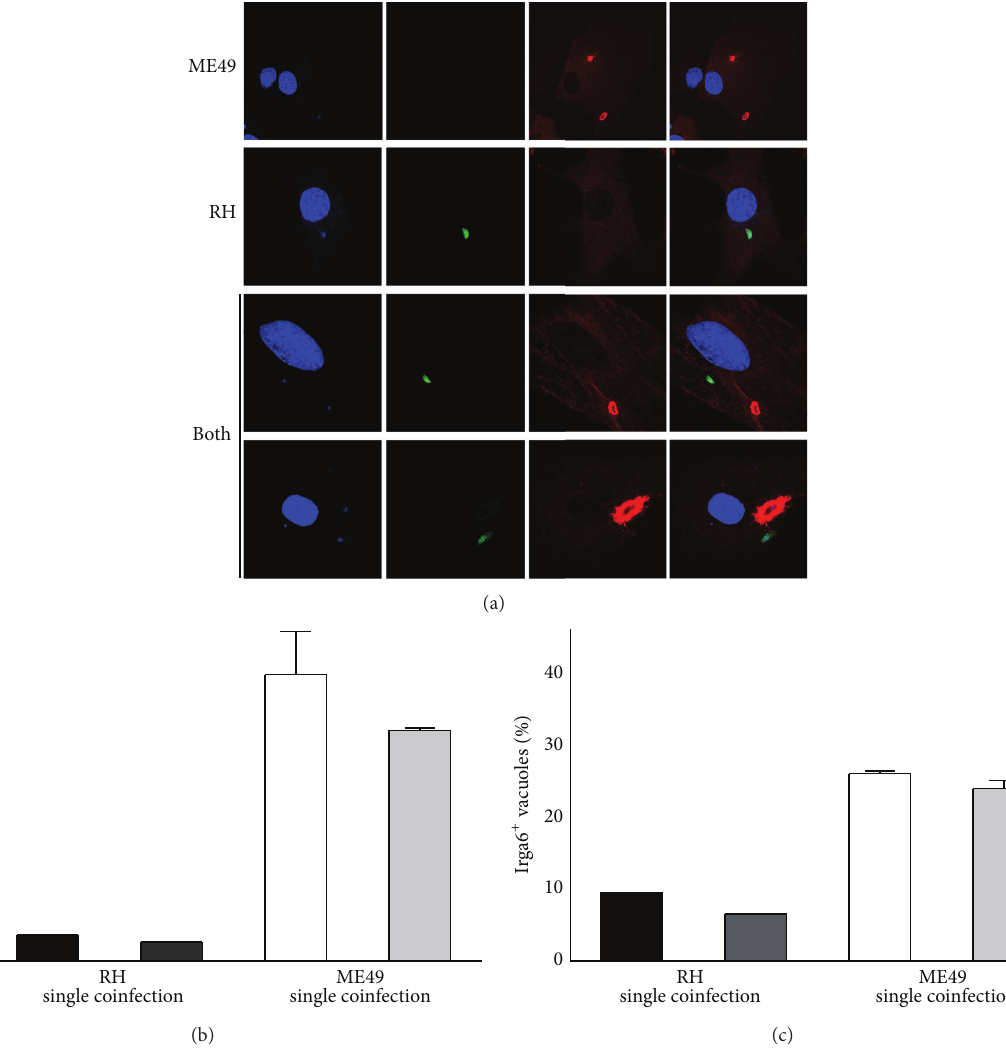
Figure 4: Accumulation of Irga6 in astrocytes coinfected with virulent and avirulent T. gondii . Astrocytes were prestimulated with IFN 𝛾 (100U/mL) and pulse-infected with either ME49 or RH or simultaneously infected with both strains. (a) Cells were stained for Irga6 (red), costained with DAPI, and analyzed in a confocal microscope. ((b), (c)) After one (b) and two (c) hours Irga6-positive vacuoles are counted in singly infected astrocytes. In comparison coinfected cells were identified containing both strains. Irga6-positive RH containing vacuoles (identified via YFP fluorescence) was distinguished from ME49 containing vacuoles and counted